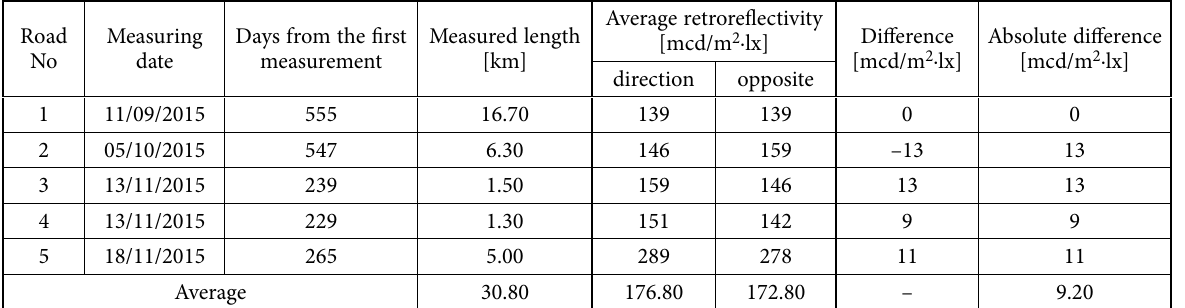
Table 4. Results of retroreflectivity measurement in the direction of application and the opposite direction for existing thermoplastic markings